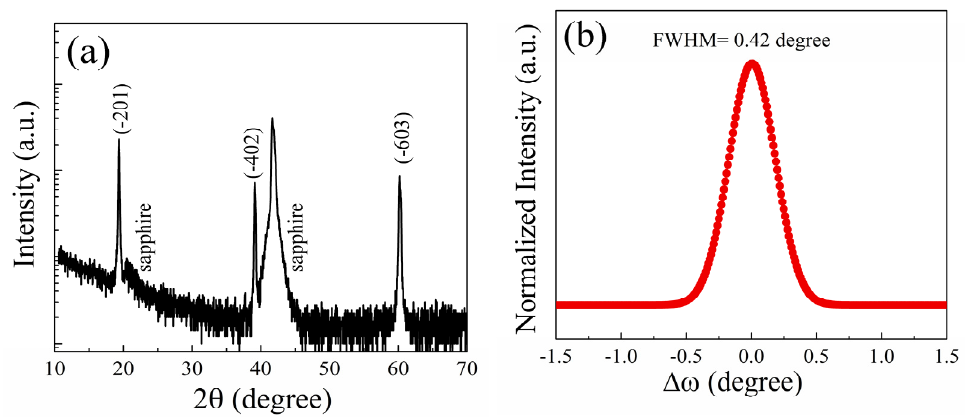
Table 1. The diffraction peak positions of β -(Al x Ga 1 − x ) 2 O 3 film and the corresponding β -Ga 2 O 3 standard diffraction peak positions.